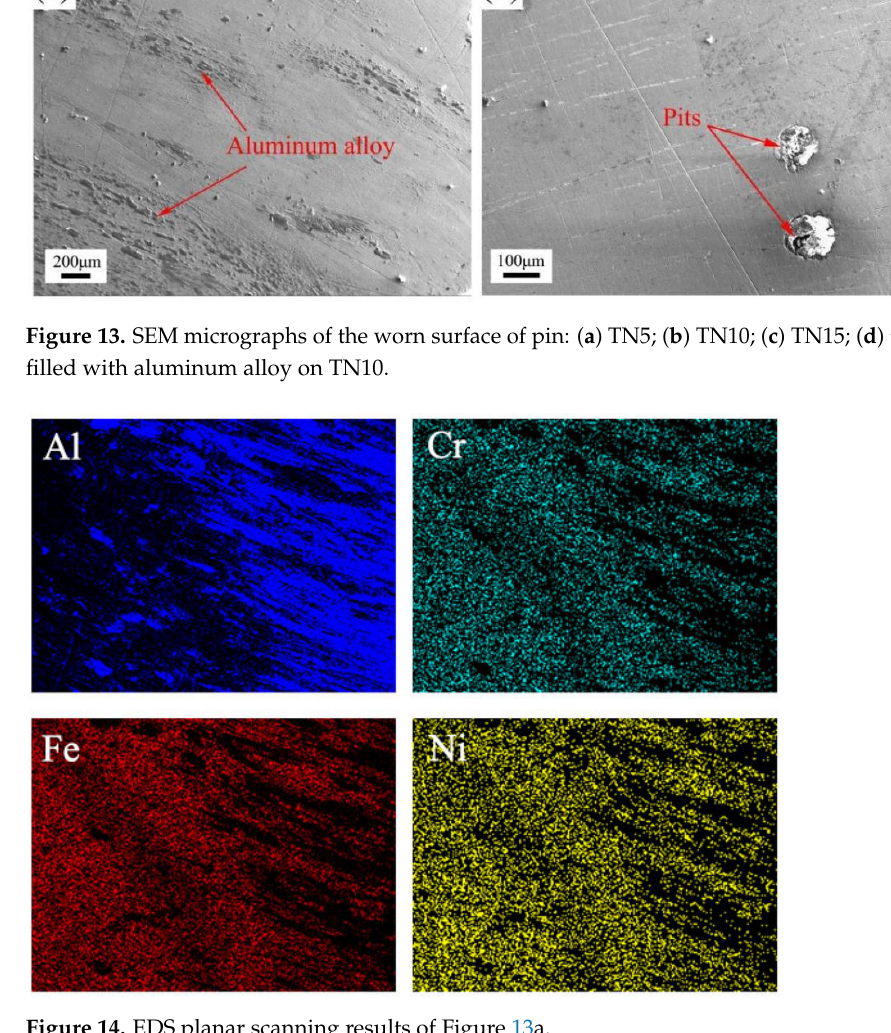
Figure 14. EDS planar scanning results of Figure 13a.